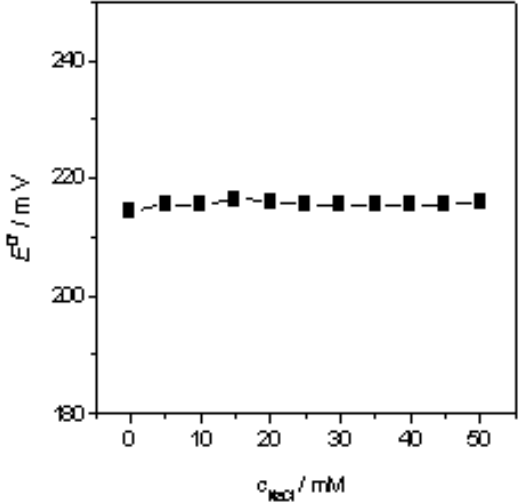
Figure 5. UV spectra of 0.5 mM M FcPF 60, 80 and 100 µ g ml -1 from (a) to (f).